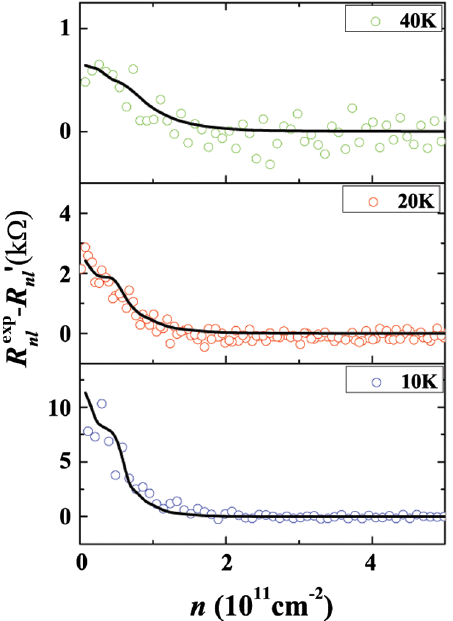
Fig.14.Intheupperpanel,redopencirclesshowthenonlocal resistance measured from sample B, and the inset is its SEM image. In the bottom panel, similar results for sample C are